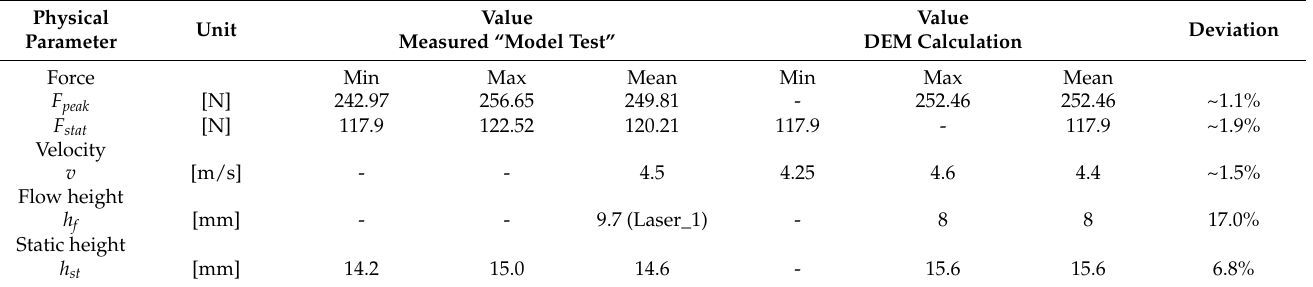
Figure 9. Comparison of the test results of the force–time history on the rigid barrier with the calculation results of the DEM simulation. Table 8. Comparison of the measured experimental results with the calculated values of the simulation results. For definitions of the parameters F dyn , F stat , v , and h f , see text.